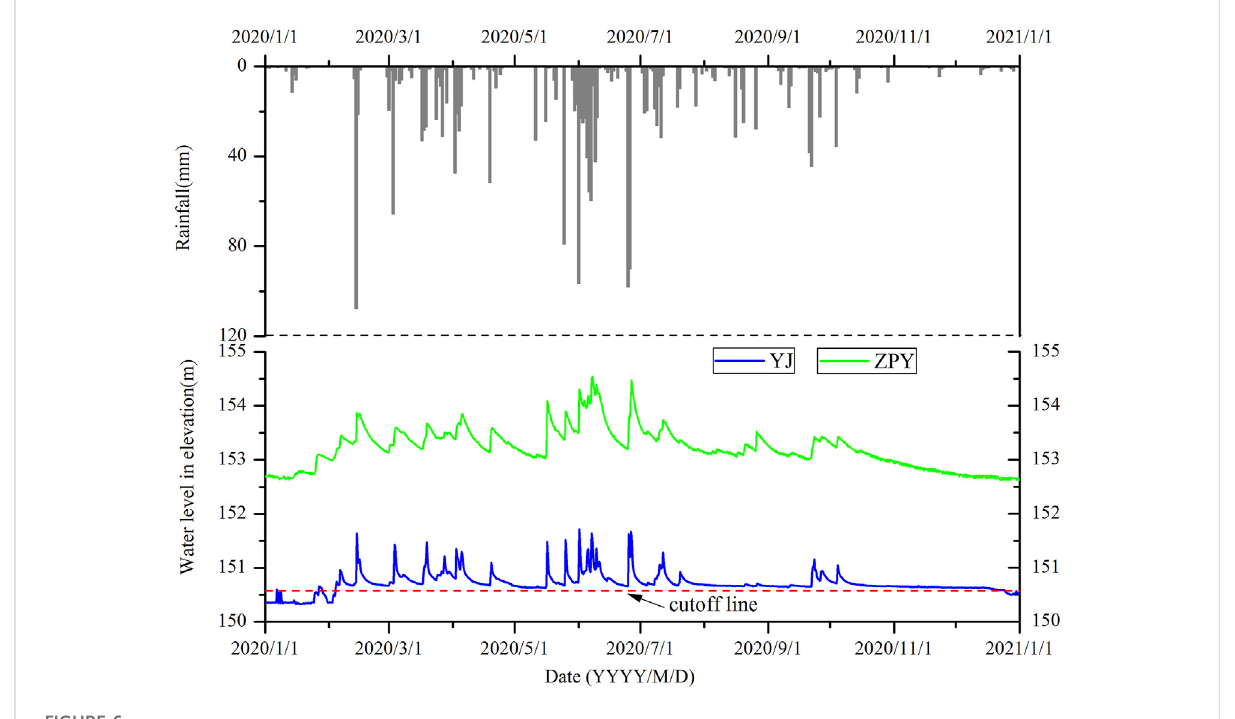
FIGURE 6 The hydrological process of two typical wetlands in Lijiang River